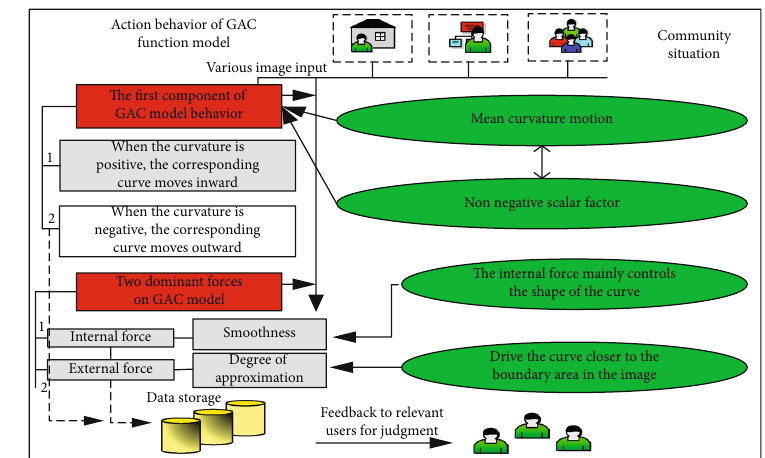
Figure 3: Action behavior of GAC model.